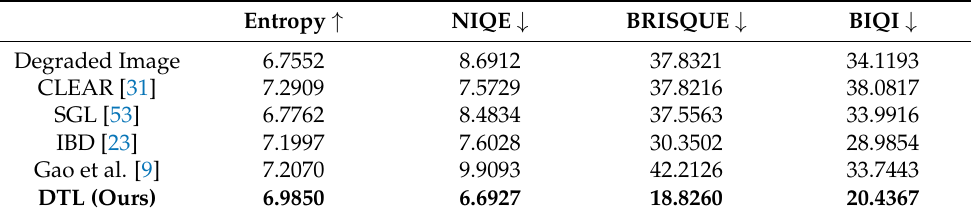
Table 6. Objective assessment of the above-mentioned restoration methods.